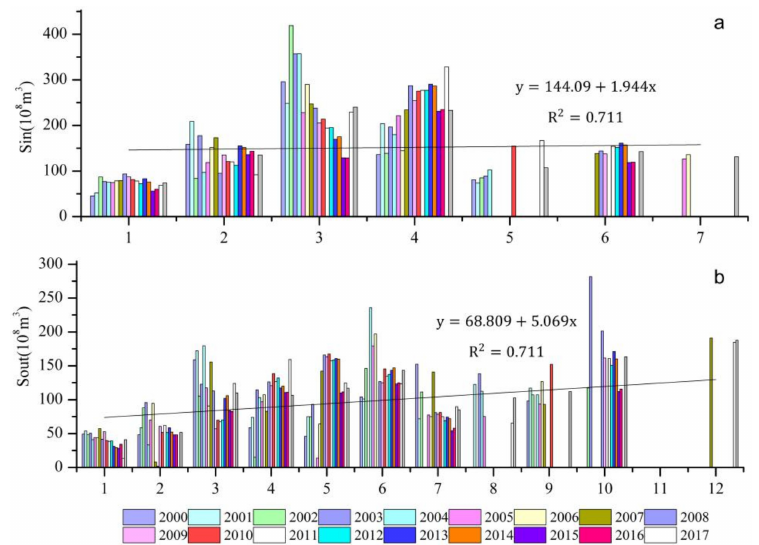
Figure 3. Node strength of virtual water trade network of China’s major crops in 2000–2017. ( a ) In-node strength. ( b ) Out-node